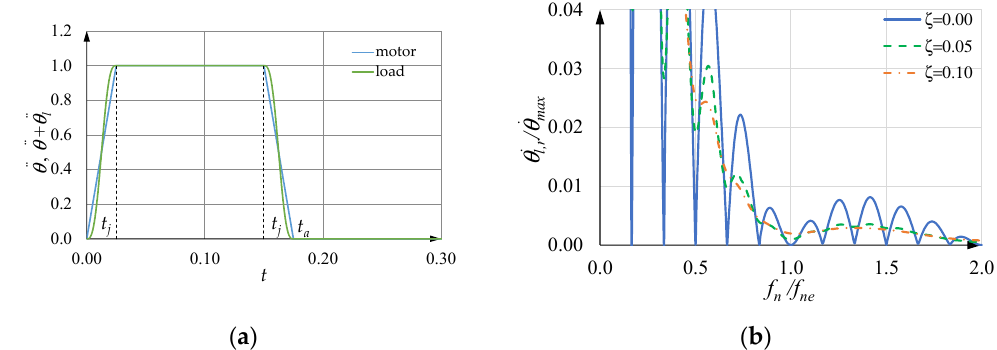
Figure 14. ( a ) Motor and load acceleration when t j = 1/ f n , e and f n = f n , e ; ( b ) sensitivity curve when t j = 1/ f n , e .